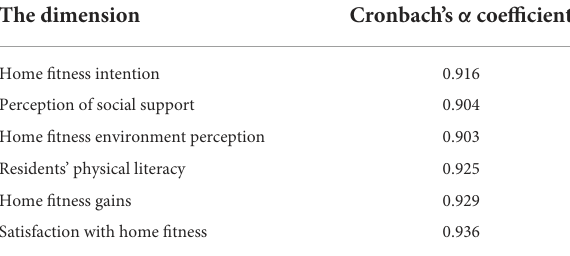
TABLE 2 Consistency analysis of each